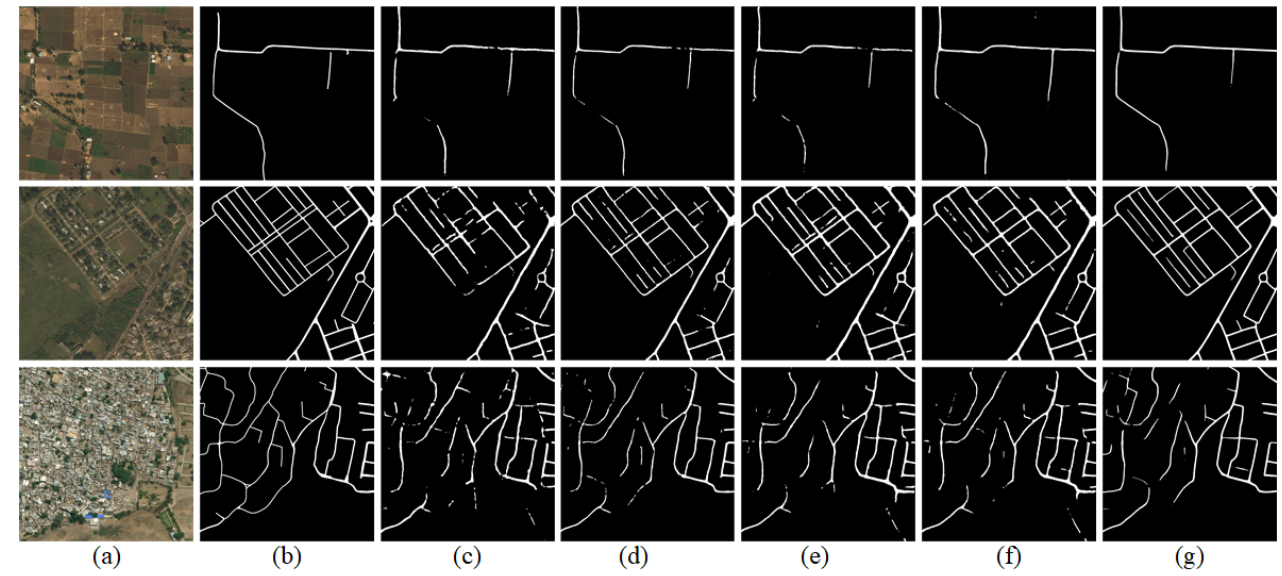
Figure 8. Visualization of segmentation results of proposed MSPNet and other methods. ( a ) Test image. ( b ) Ground Truth. ( c – g ) Road extraction results of FCN, ResUNet, D-LinkNet, SE-Deeplab and our